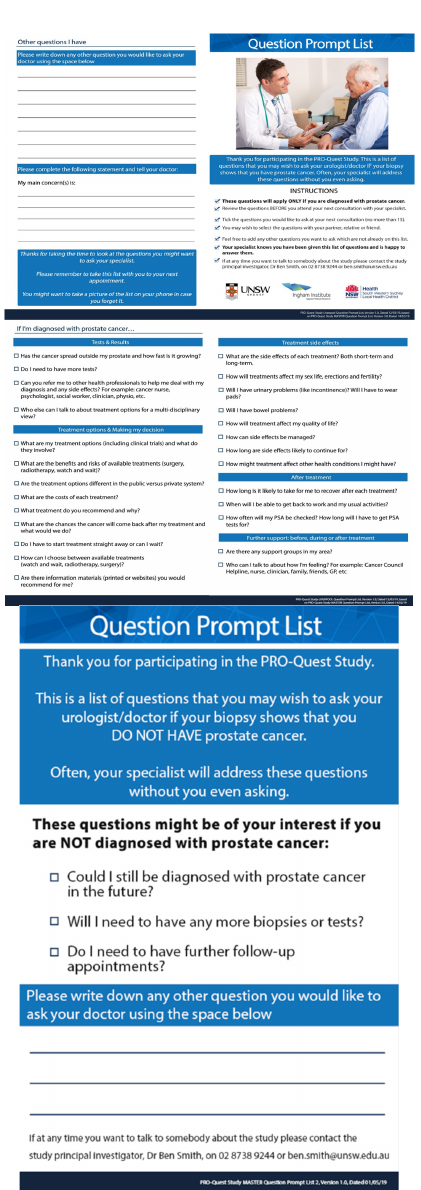
Figure A1. Question prompt list (external and internal view, and additional 1-page brochure).